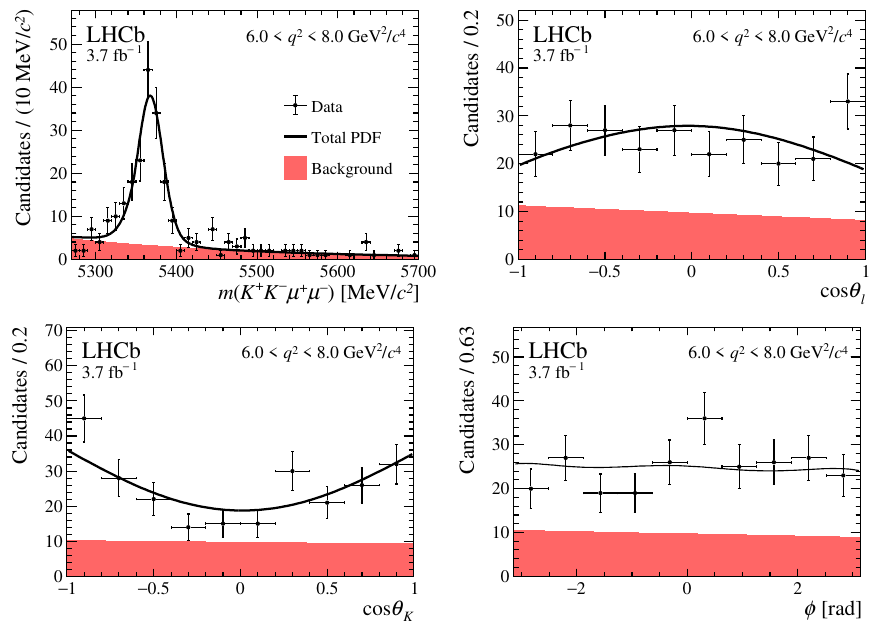
Figure 23 . Mass and angular distributions of B 0 6 . 0 < q 2 < 8 . 0 GeV 2 /c 4 for data taken in 2017–2018. The data are overlaid with the projections of the fitted